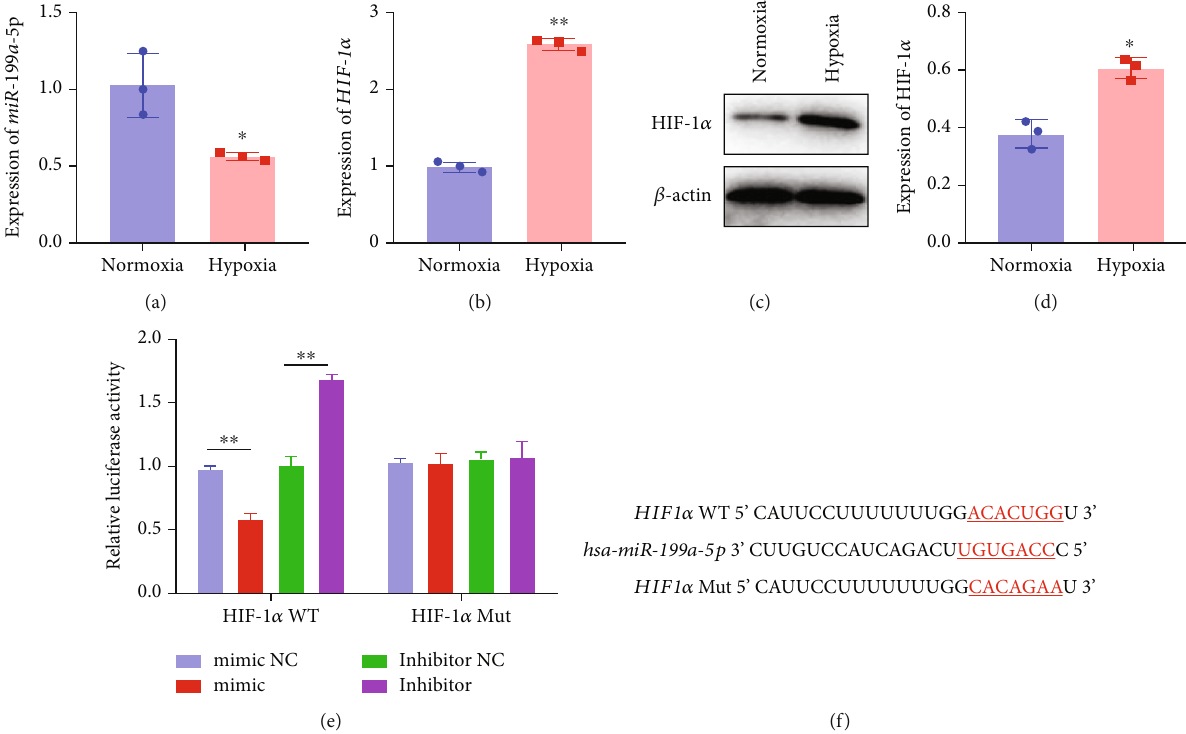
Figure 5: miR-199a-5p targeted HIF-1 α . mRNA expression of (a) miR-199a-5p and (b) HIF-1 α in A7r5 cells under normoxia and hypoxia (1% O ) by qRT-PCR. (c) Protein expression of HIF-1 α in A7r5 cells by western blot and (d) quanti fi cation. (e) Luciferase reporter assay to 2 validate the putative (f) miR-199a-5p-binding site in the 3 ′ -UTR of HIF-1 α . WT: wild type; Mut: mutant; NC: negative control. ∗ P < 0 : 05 , ∗∗ P < 0 : 01